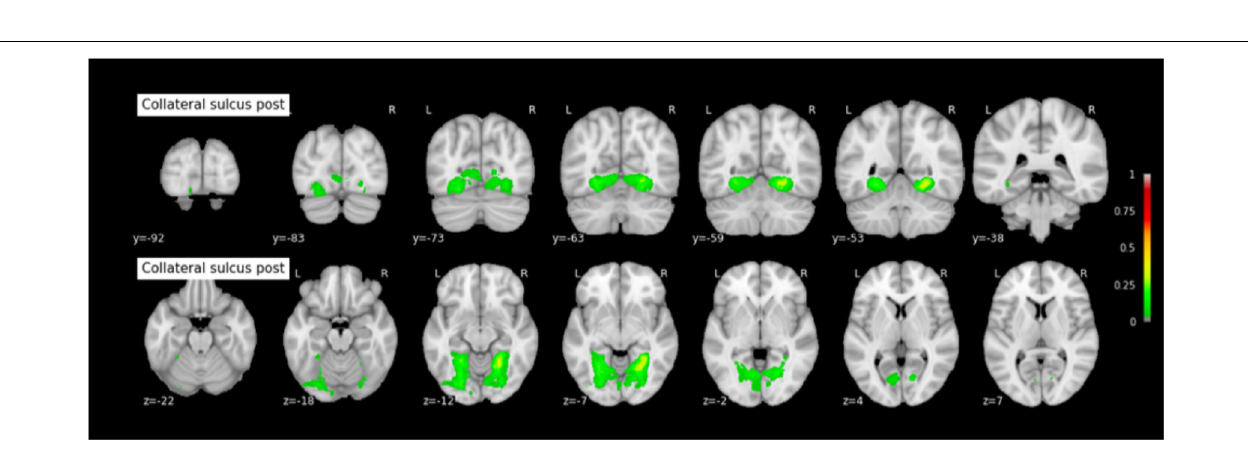
FIGURE 6 | Probabilistic map of the collateral sulcus post (CS post). The maps are normalized into the MNI stereotaxic space. Coordinates are indicated on each slice.